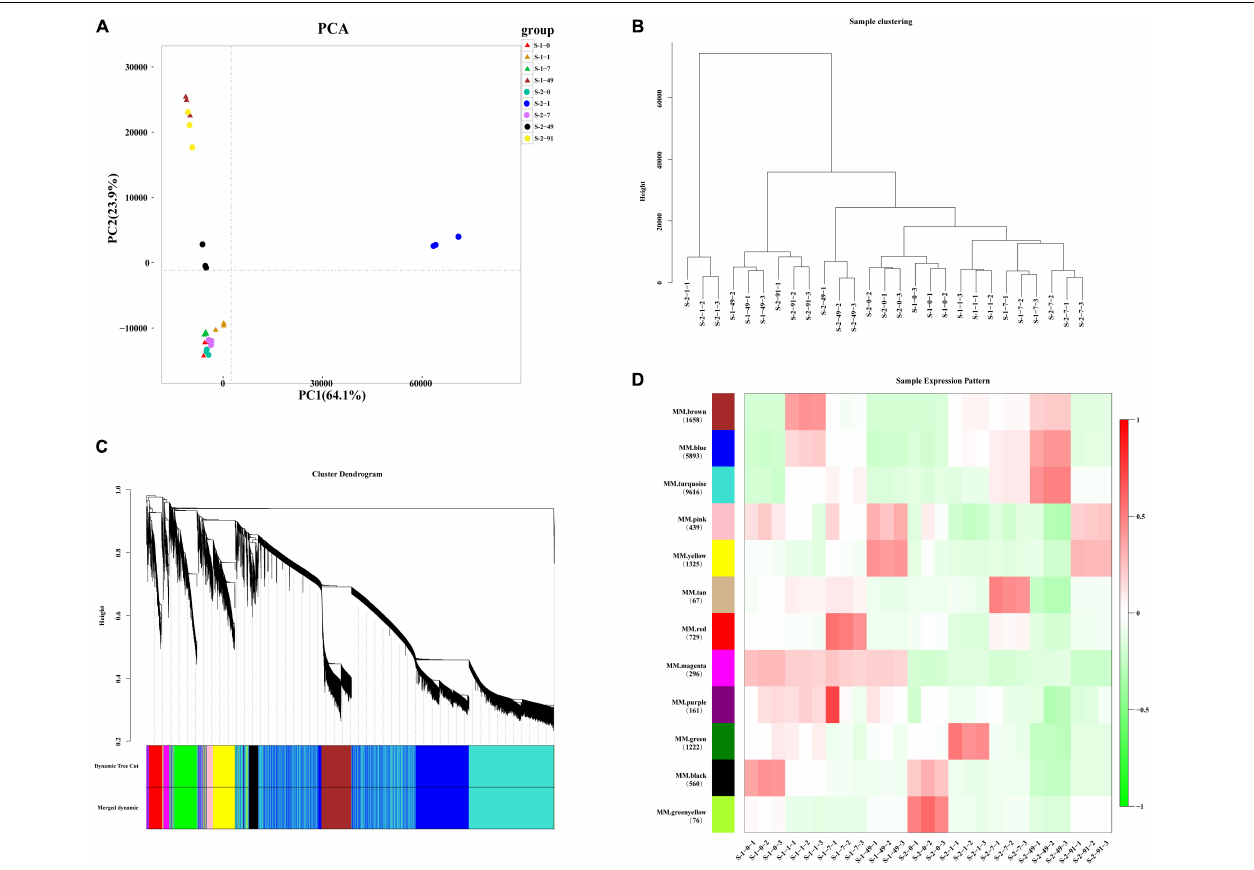
FIGURE 2 | Principal coordinate analysis (PCA) and Weighted Gene Co-Expression Network Analysis (WGCNA) of Pyropia haitanensis transcript profiles. (A) PCA of expression patterns of 47,046 unigenes at different developmental stages in S-1 and S-2 strains. (B) Sample clustering of 27 samples, each smallest branch represents a sample, and each larger branch represents their clustering relationship. (C) Clustering dendrogram and modules for 22,042 unigenes. Each gene is represented by a leaf in the tree. Y axis represents network distance, as determined by topological overlap. Different colors show module membership after being merged. (D) Module–trait relationships. Colors on the left represent 12 modules and the numbers of unigenes are noted in each module. Heat-map shows the module eigengene correlations with traits (27 samples in this